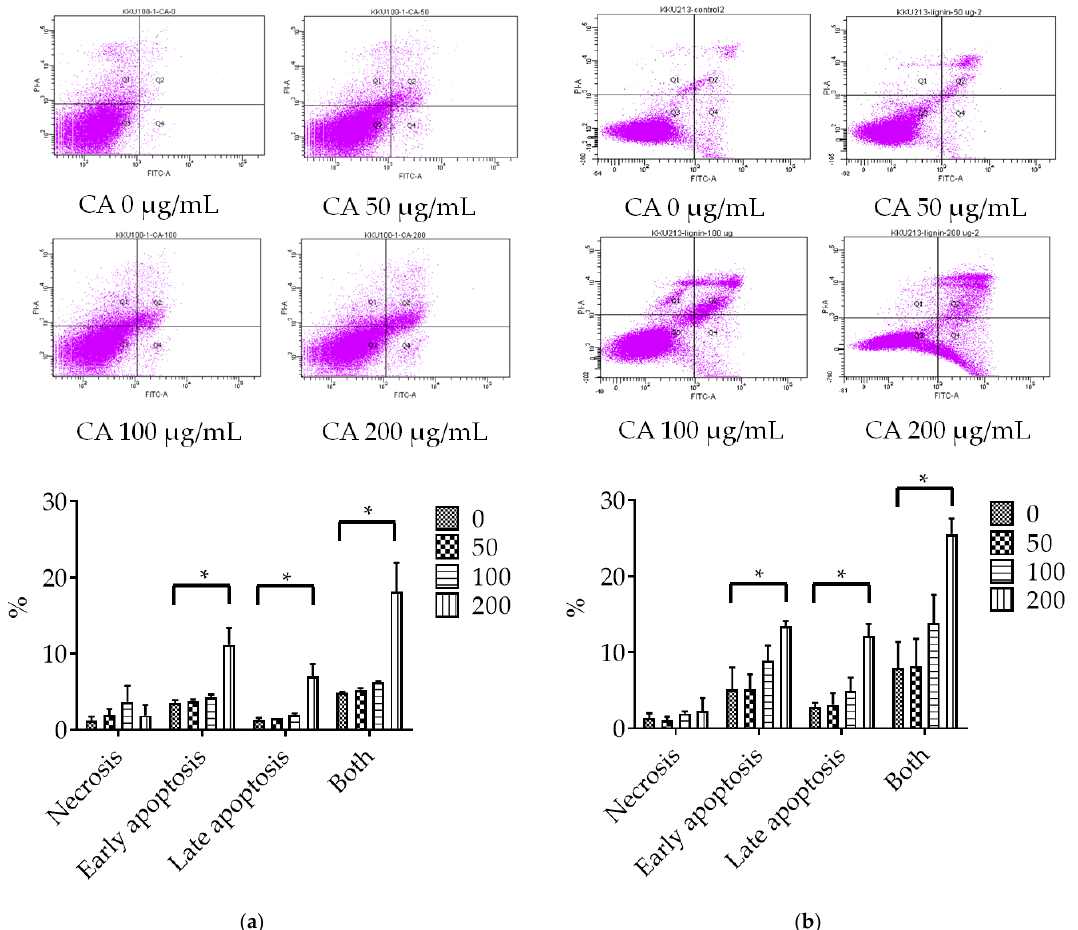
Figure 2. Flow cytometric analysis of apoptotic cells of ( a ) KKU-100 and ( b ) KKU-213 cell lines stained with propidium iodide and FITC-Annexin V after treatment with CA for 48 h. (Data was presented in triplicate.* = statistically significant; p -value < 0.05).